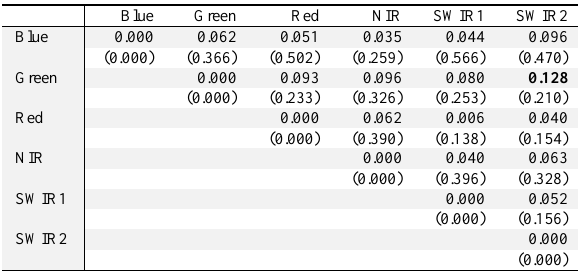
Table 2. Band-to-band mean (and standard deviation) pixel residuals in the horizontal direction (worst value in bold) Blue